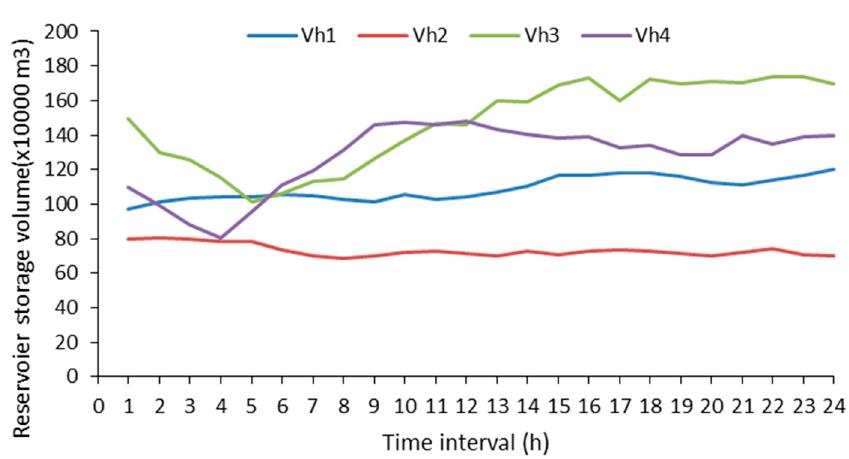
Figure 8. Hydro plant reservoir storage volume curves.